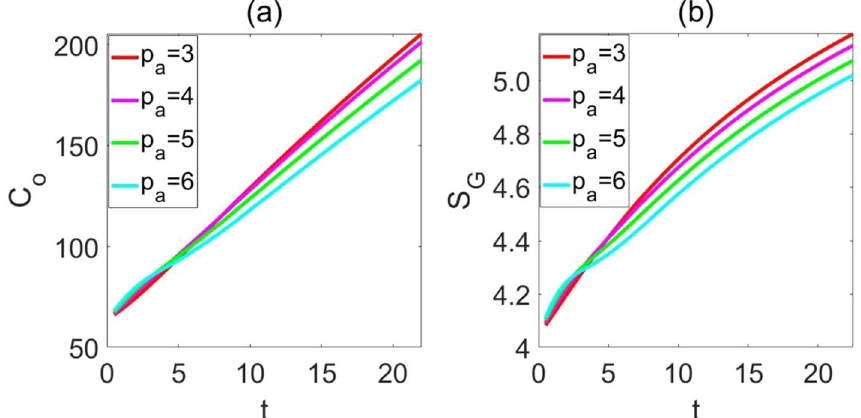
coherence and b Gibbs entropy as functions of the time